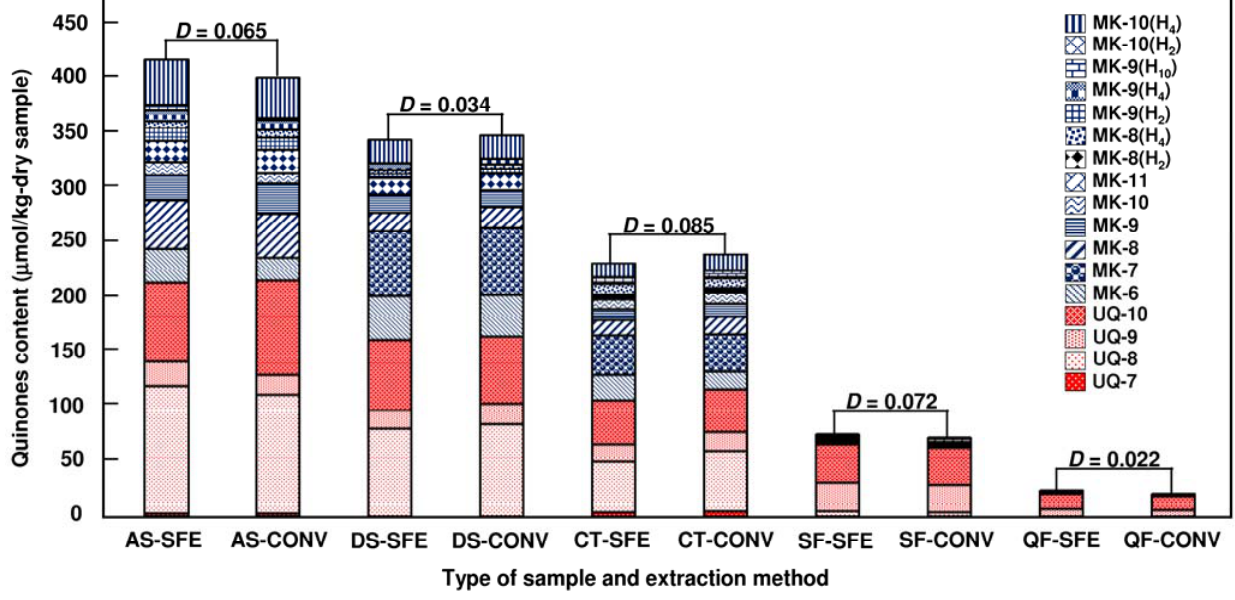
Figure 5. Comparison of the quinone compositions by supercritical fluid extraction (SFE) and an conventional organic solvent extraction (CONV) method in environmental and biological samples; activated sludge (AS); digested sludge (DS); compost (CT); swine feces (SF); quail feces (QF). The D values represent the dissimilarity index; the data show the average value of three different determinations for each